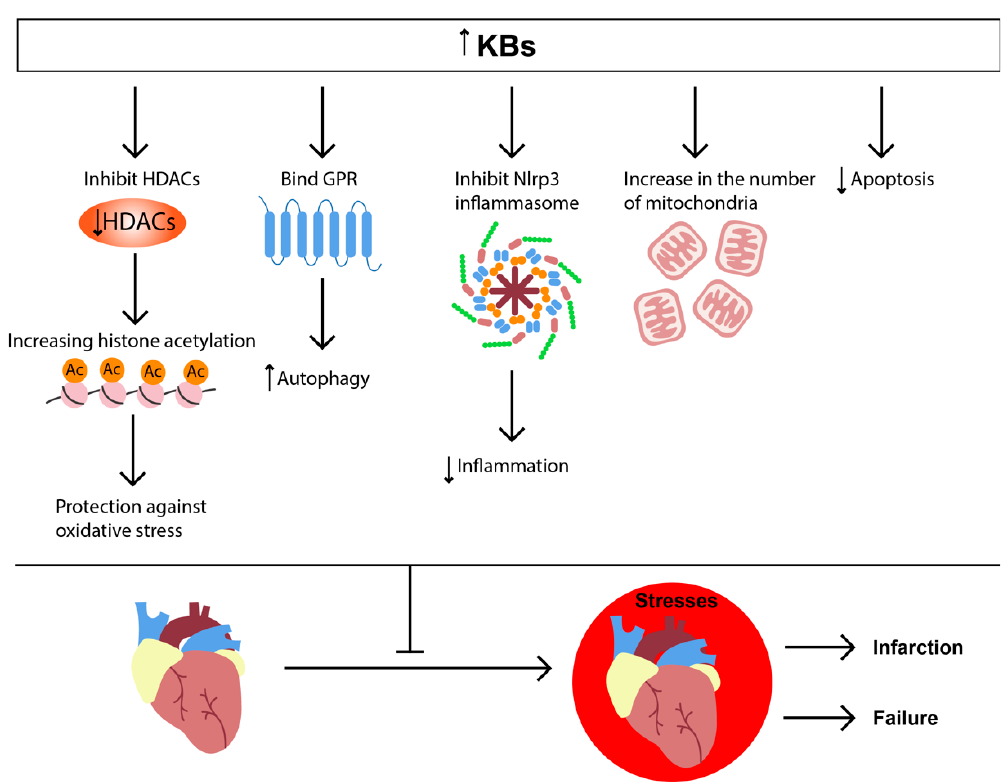
Figure 4. KB signaling in heart pathologies. The increased concentration of KBs leads to binding with GPR, inhibition of HDAC and NLRP3-inflammasome, increase in the number of mitochondria, and decrease of apoptosis. These effects protect the heart by enhancing autophagy and reducing inflammation and ROS production.